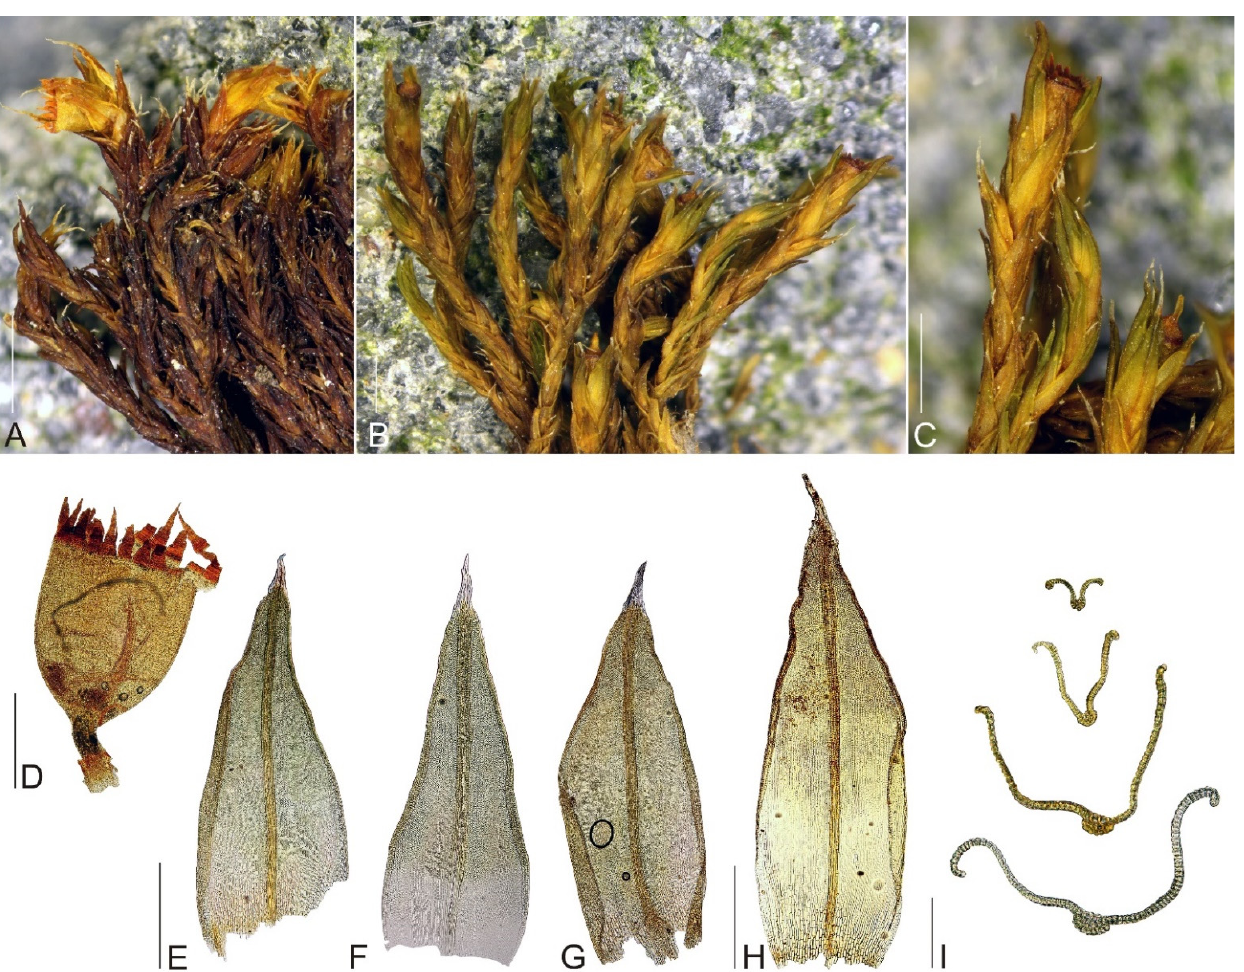
Figure 3. Macro and micro photographs of Schistidium pulchrum : ( A – C ) view on fertile plants; D — capsule ; ( E – G ) leaves; ( H ) perichaetial leaf; ( I ) leaf cross-sections (from the base of the leaf to the tip). Scale bars: A – C —1 mm, D – H —0.5 mm, I —0.1 mm. All photos from specimen OSTR #7252, made by V. Plášek.